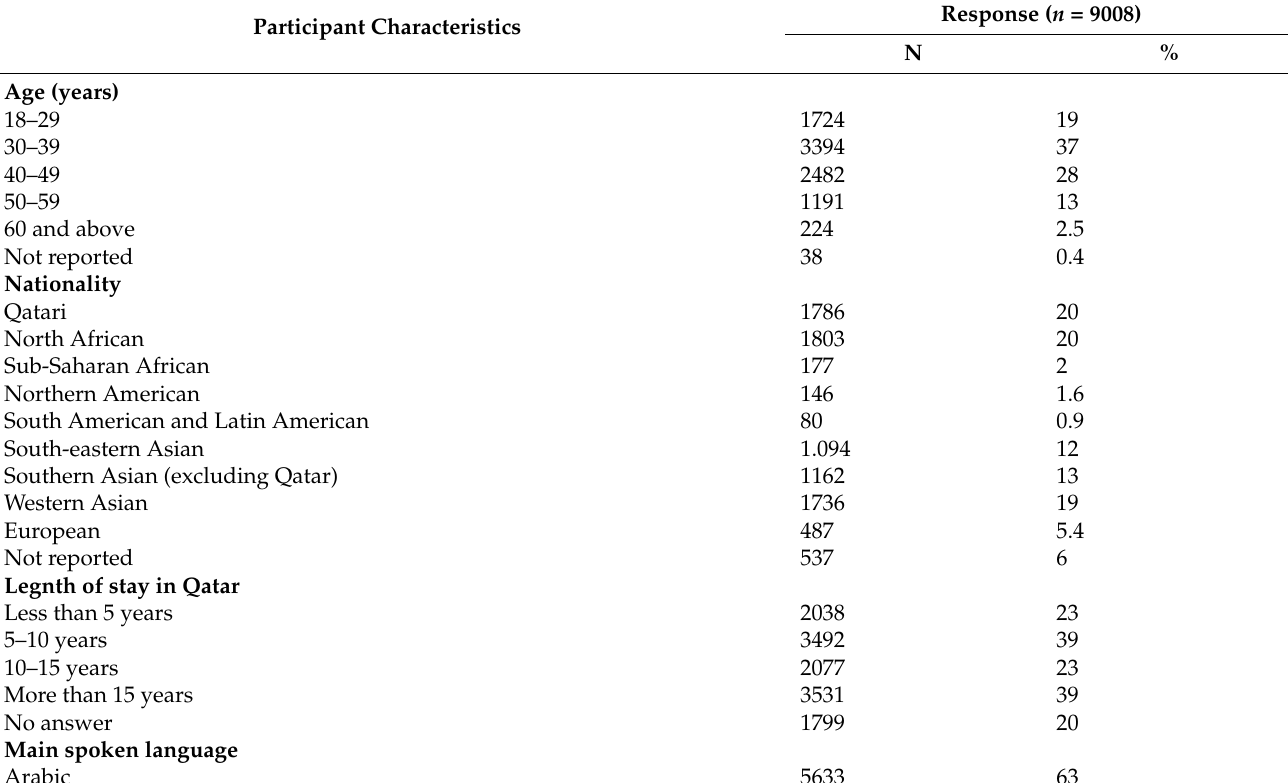
Table 1. Participant